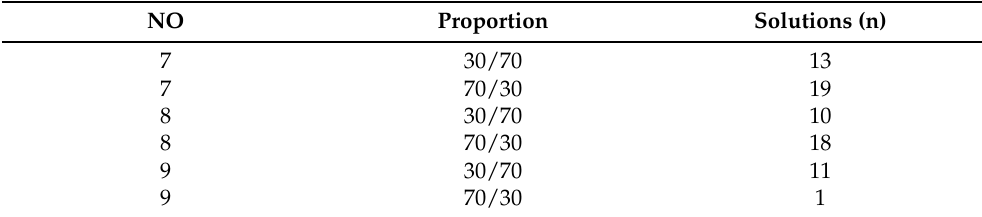
Table 4. Number of non-dominated solutions found for each scenario in the initial